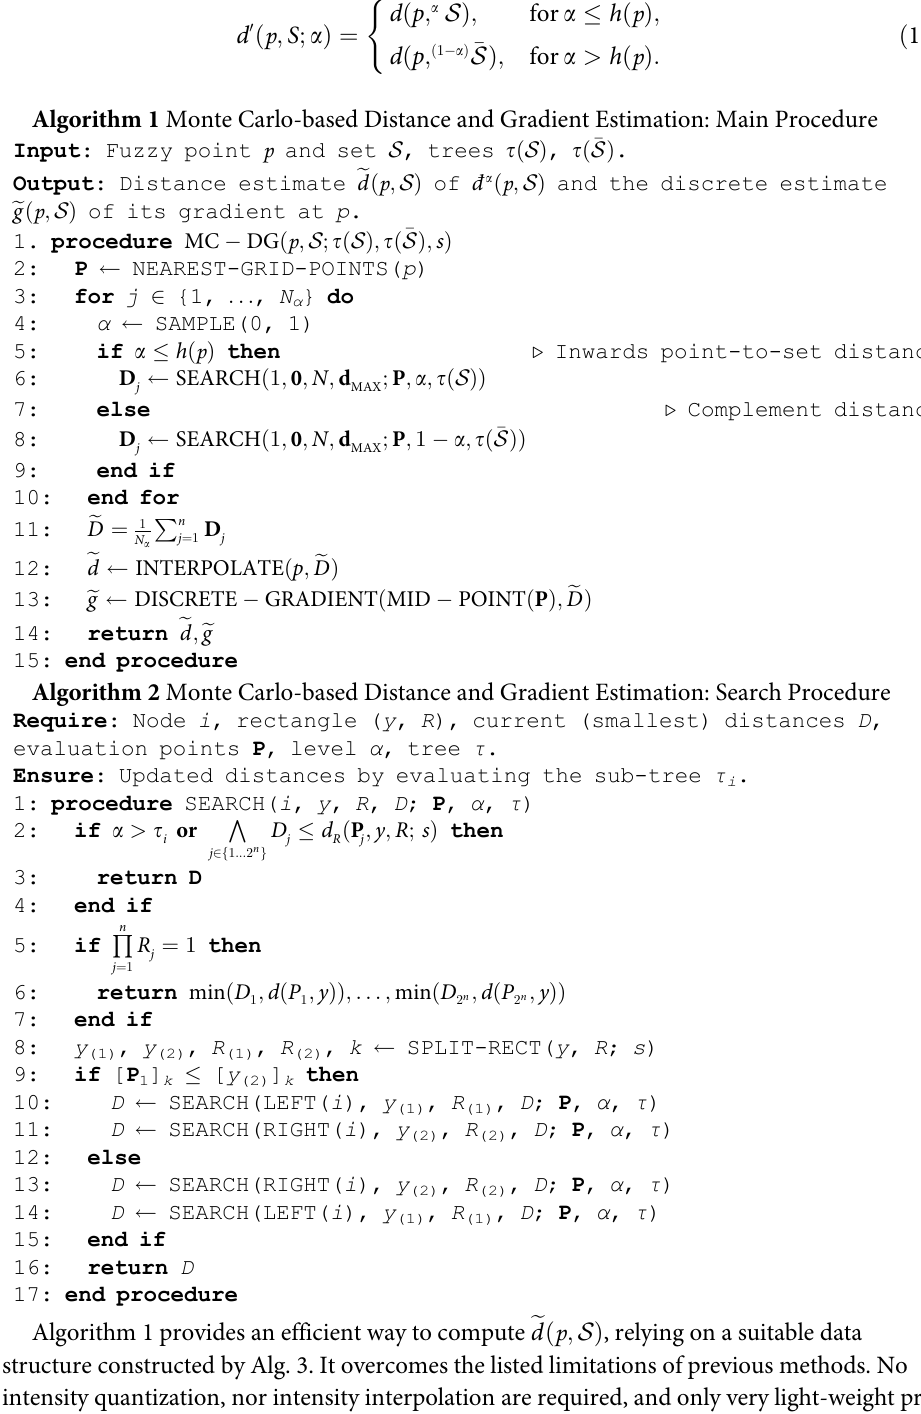
Algorithm 3 Construction of Data-Structure for Monte Carlo based estimation of point-to- set Distance and